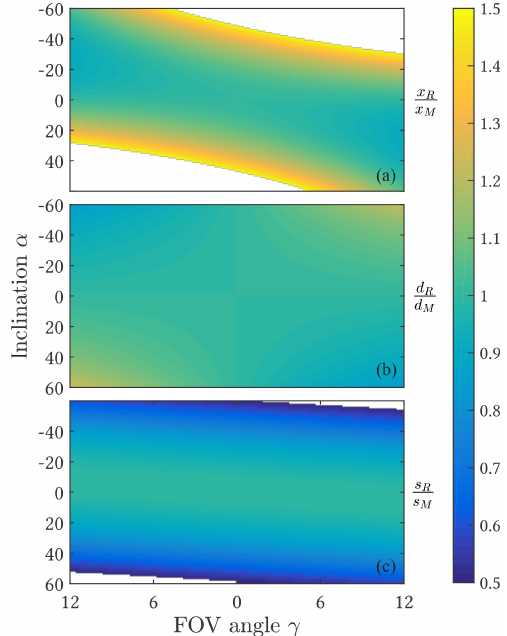
Figure 5. Ratio of the real variables to the measured variables of the velocity (upper panel), plume distance or diameter (middle panel) and column densities (lower panel) for an SO 2 camera with an FOV angle of 24 ◦ . The relative deviations of distance are the same as for = d R the diameter ( h R ). Relative deviations larger than 0.5 from h M d M the measured data are shaded white.